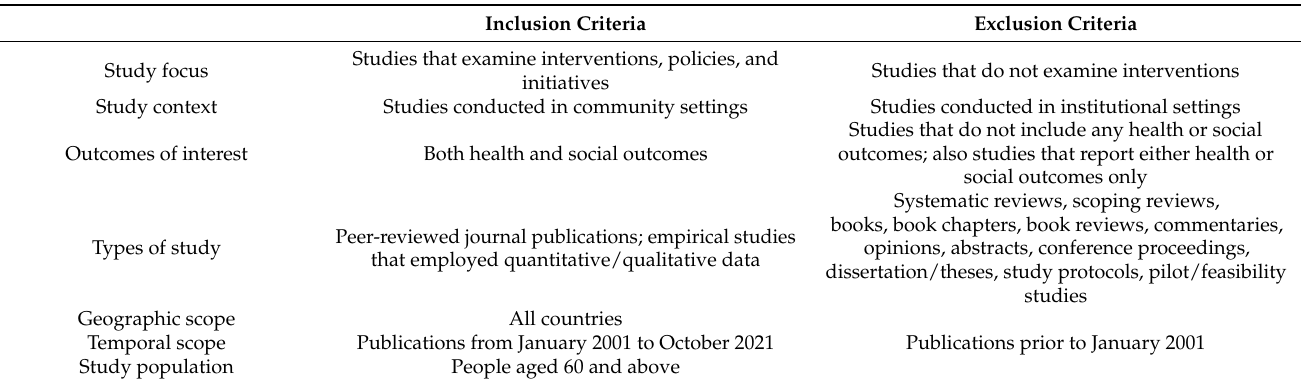
Table 2. Study inclusion and exclusion criteria.